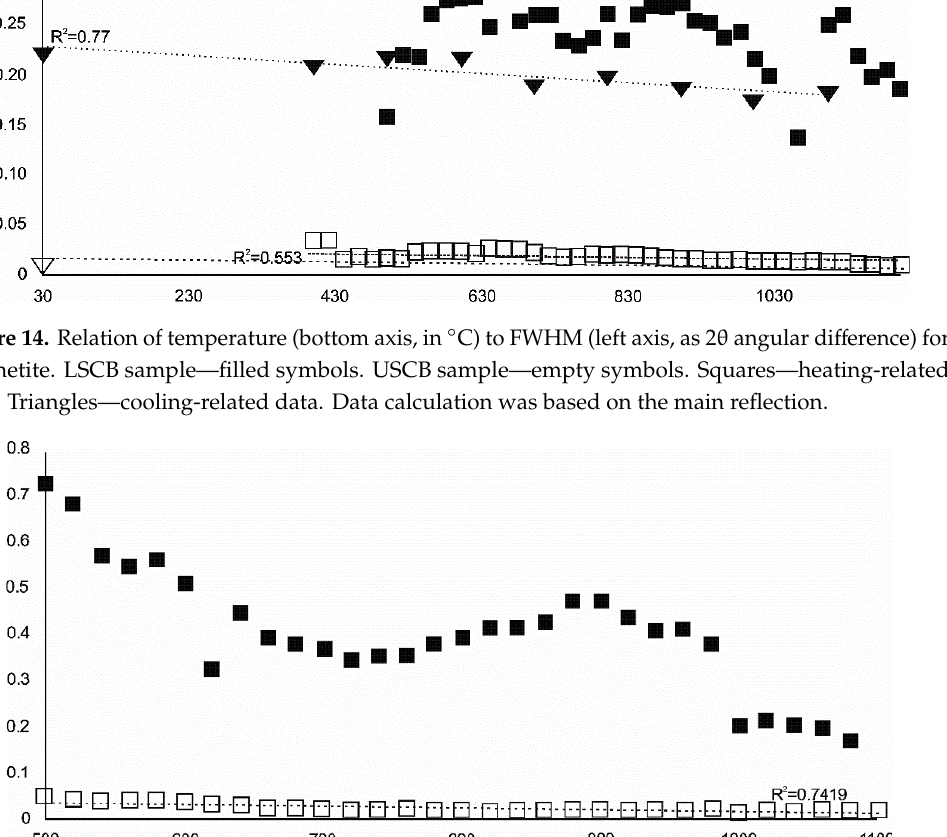
Figure 15. Relation of temperature (bottom axis, in °C) to FWHM (left axis, as 2 θ angular difference) for wüstite. LSCB data—filled symbols. USCB data—empty symbols. Data calculation was based on the most intense reflection.